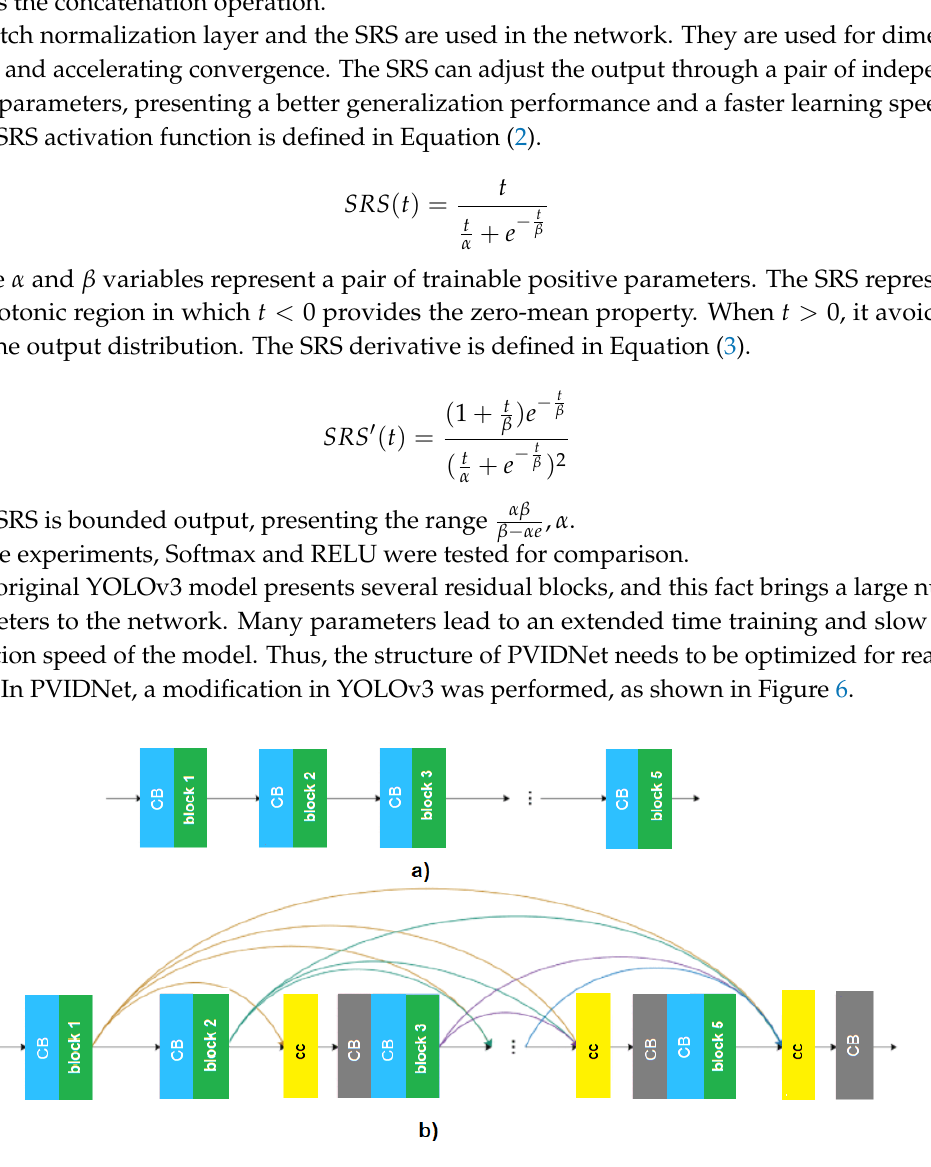
Figure 6. ( a ) representation of the backbone structure of the original YOLOv3; ( b ) representation of the backbone structure of